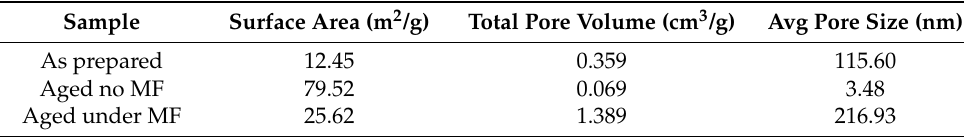
Table 1. Effect of MF for surface area and pore volume parameters of samples.